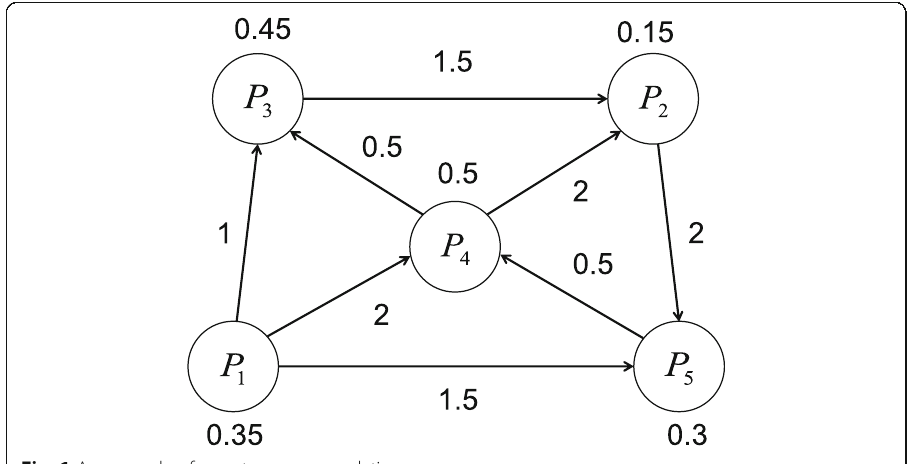
Fig. 1 An example of a route